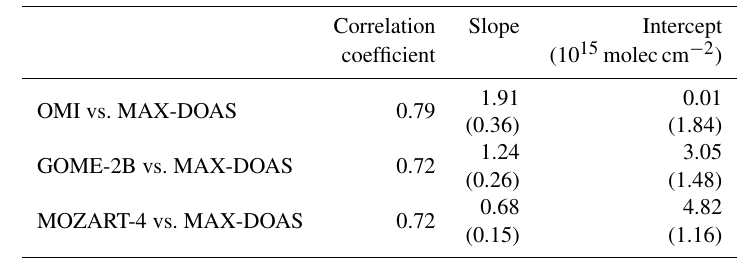
Table 2. Correlation, slope, and intercept between HCHO MAX-DOAS and satellite measurements as well as model simulations. The values in brackets are the standard errors for slope and intercept.